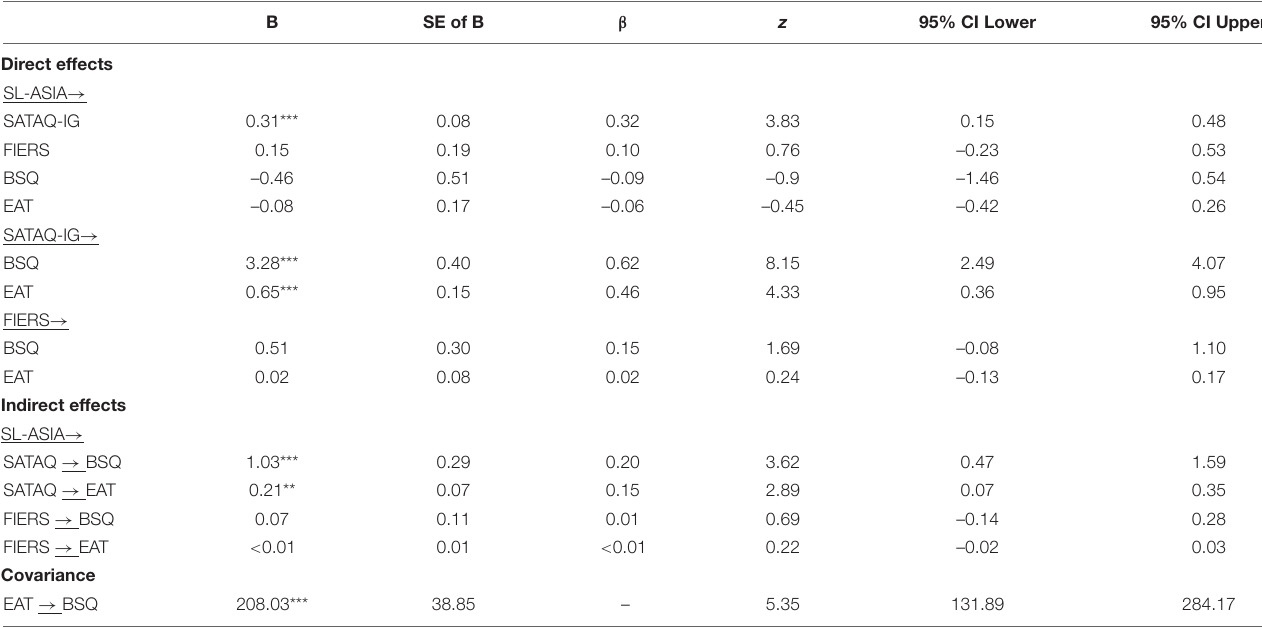
TABLE 3 | Summary statistics for direct and indirect effects in the path